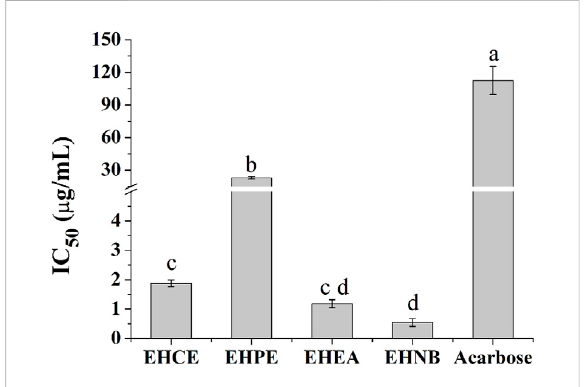
curve analysis function in GraphPad Prism 8.0.1.2 (GraphPad